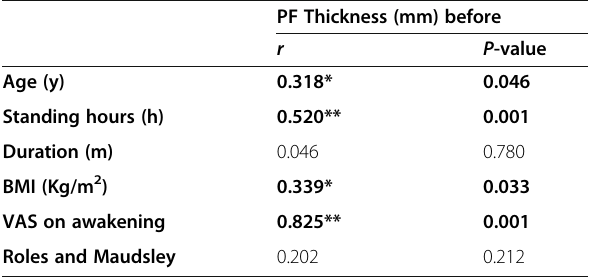
Table 2 Pearson correlation analysis results of PF thickness before ESWT with the studied